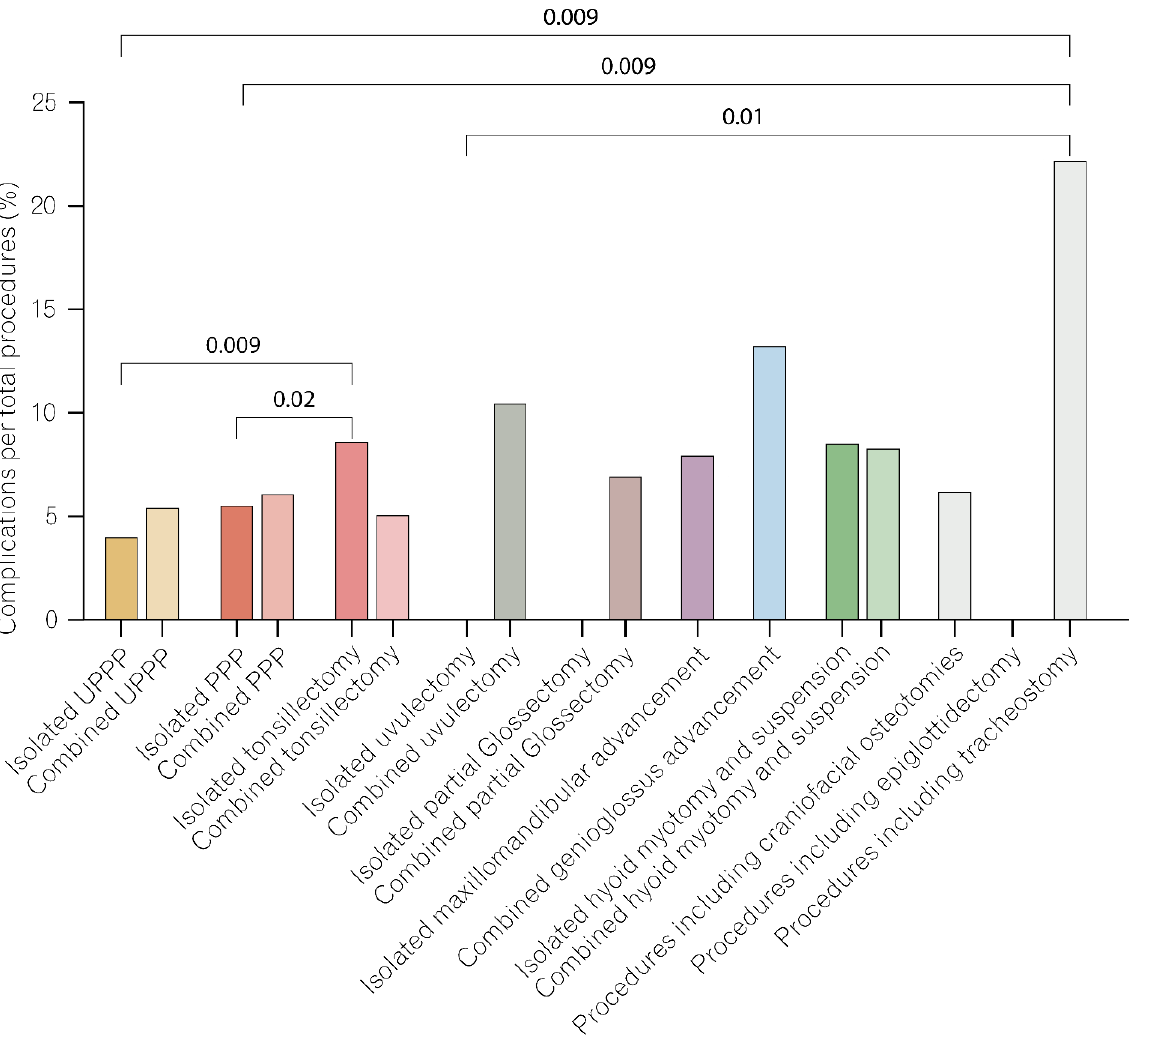
Figure 2. Complications rates for different procedures. Isolated and combined procedures did not significantly differ in terms of complication rates. Tonsillectomy, when performed as an isolated procedure, had a significantly higher rate of complications than isolated UPPP or isolated PPP. Tracheostomy procedures had the highest rate of complications, significantly higher than isolated UPPP, isolated PPP, and isolated uvulectomy. The exact numbers are shown in Supplementary Tables S2 and S3.